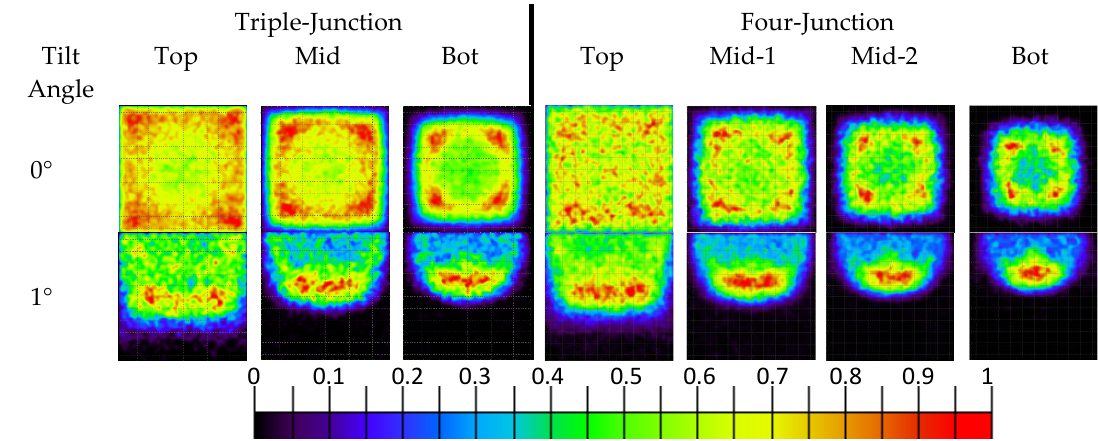
Figure 7. Normalized J sc,iconc spatial distributions of each subcell under normal alignment and under 1° of tilt angle respect to the incoming light.